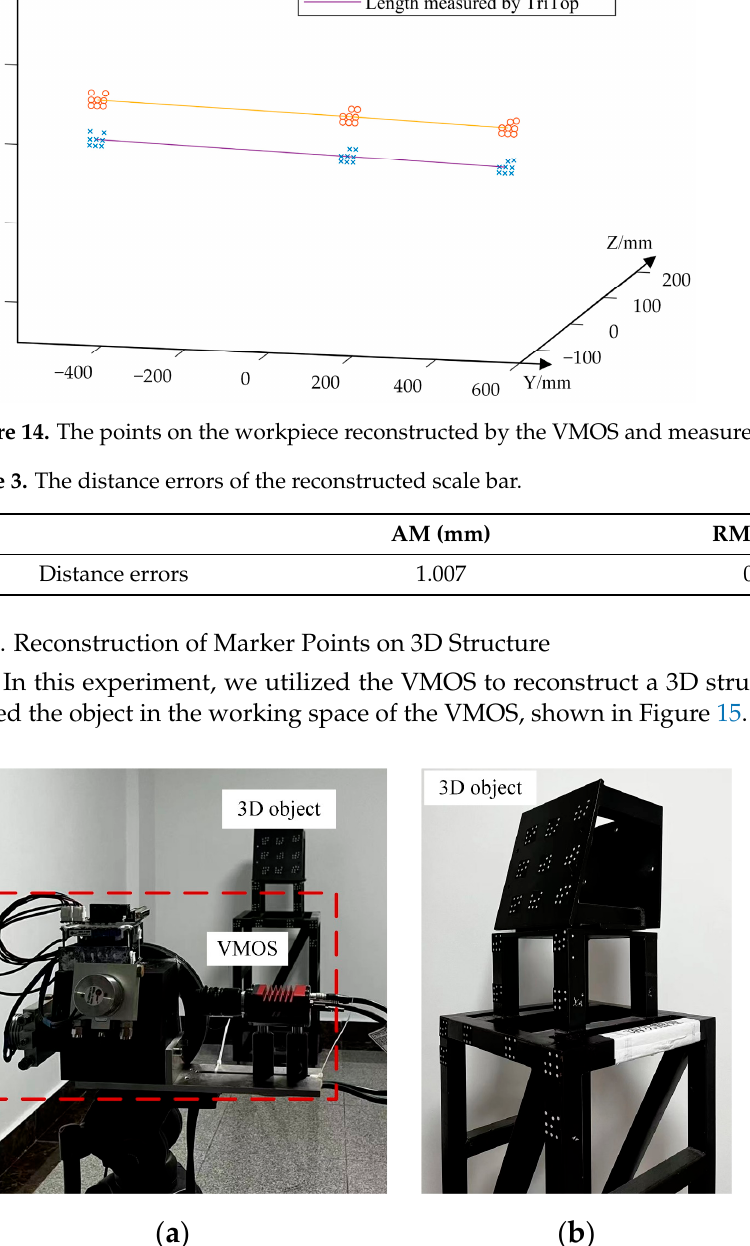
Table 4. Reconstruction errors of 19*8 coded points on the 3D object.